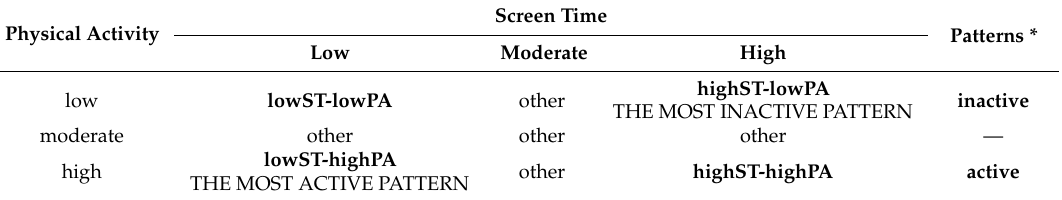
Table 1. Activity–inactivity patterns categorized as screen time (ST) or physical activity